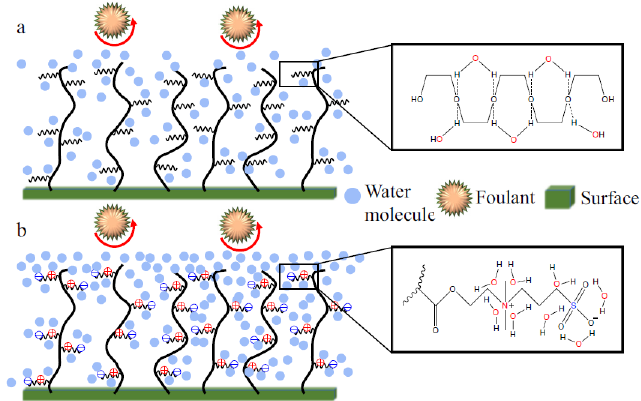
Figure 10. Schematics comparing the interactions of zwitterions and PEG with water. ( a ) One PEG repeat unit forming a hydrogen bond with one water molecule; ( b ) one zwitterion chain interacting with eight water molecules through electrostatic forces [58]. Reproduced with permission, Elsevier B.V., 2016.